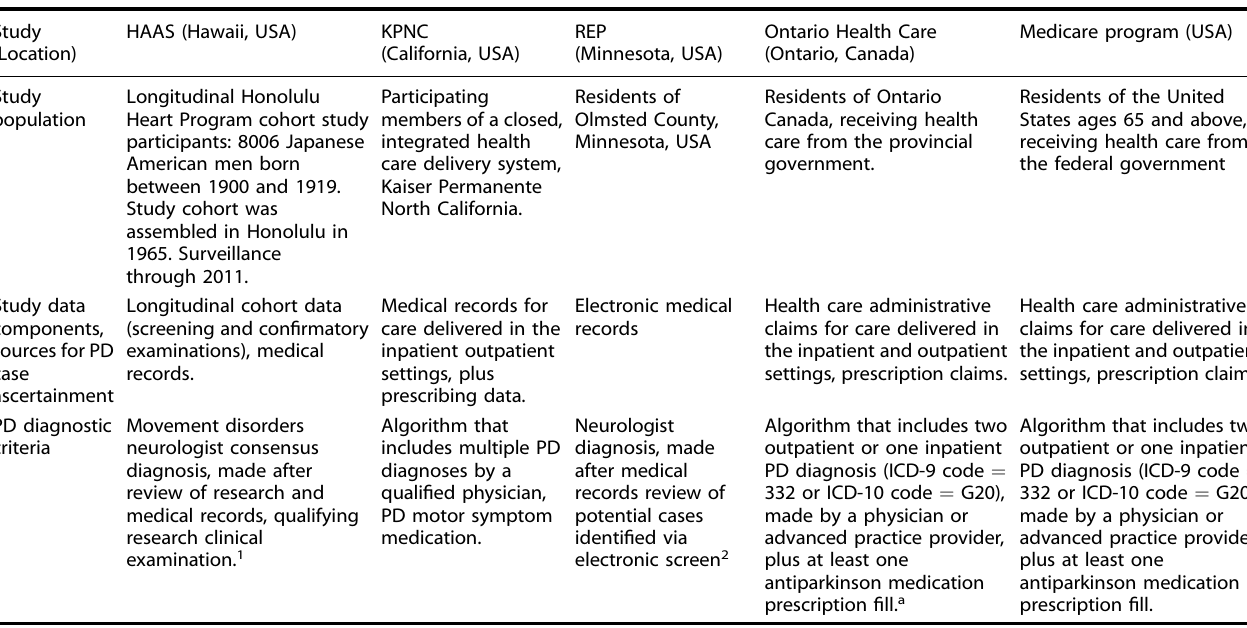
Table 4. Study populations and case ascertainment